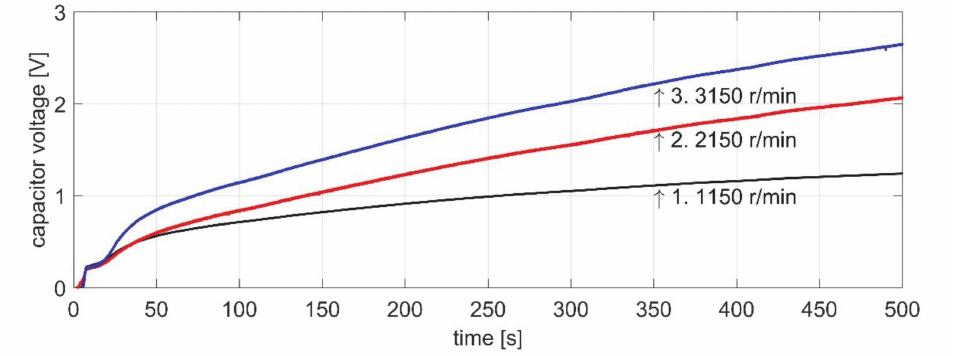
Figure 14. Voltages for three given rotor speeds, d = 20